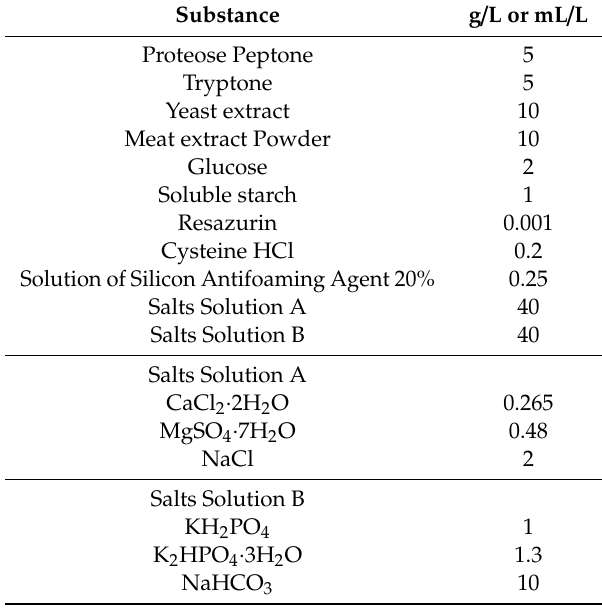
Table 1. Composition of peptone yeast extract glucose starch. Substance g / L or mL /